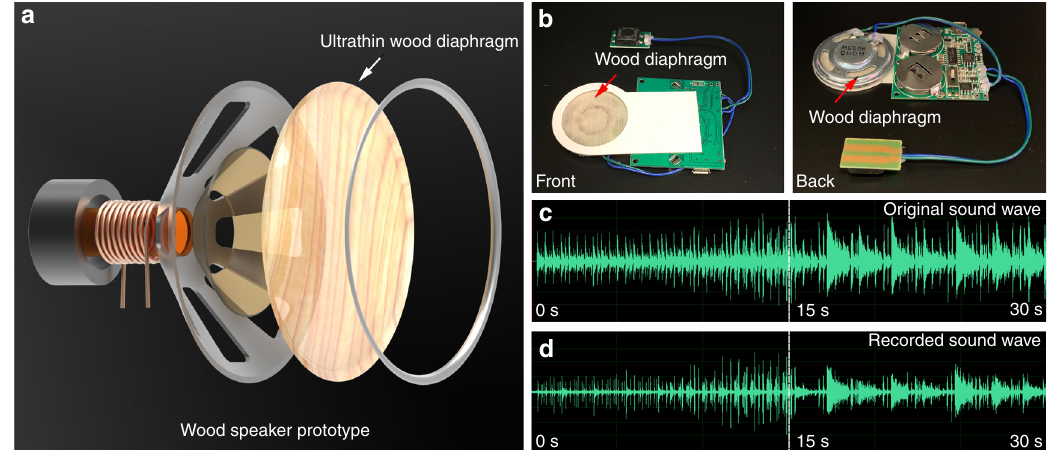
Fig. 5 Wood speaker prototype. a Schematic of the wood speaker prototype. b Photographs of the speaker with the wood diaphragm. c The sound wave of the original song (Spain Matador March). d The recorded sound wave (Spain Matador March) of the speaker with the